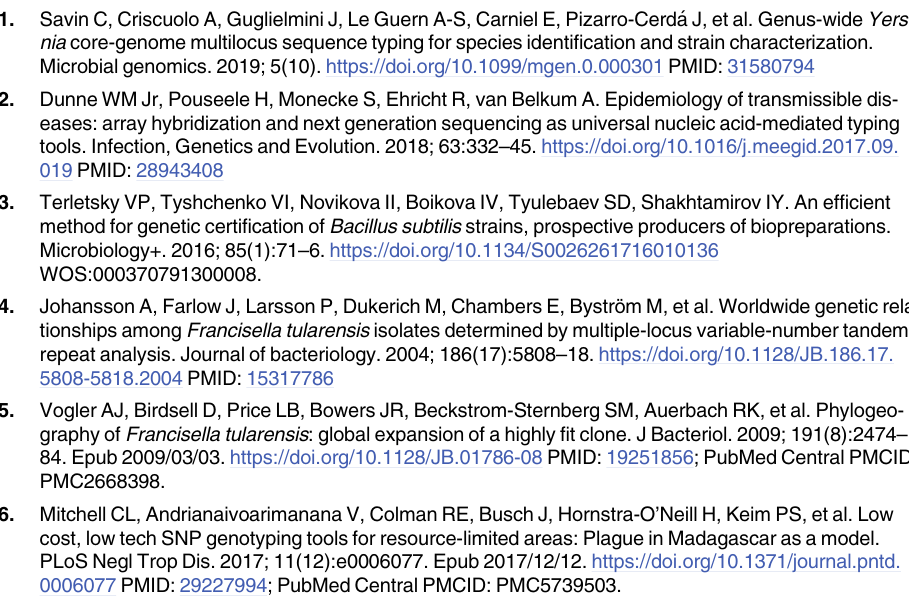
S2 Table. Primers for in silico MLVA7. S3 Table. MLVA results obtained by in vitro and different in silico methods. S4 Table. Number of raw reads containing the Ft-M3 locus and flanking primers (as indi- cated in S2 Table) detected in the 39 sequence reads datasets in view of the repeat copy number and dataset